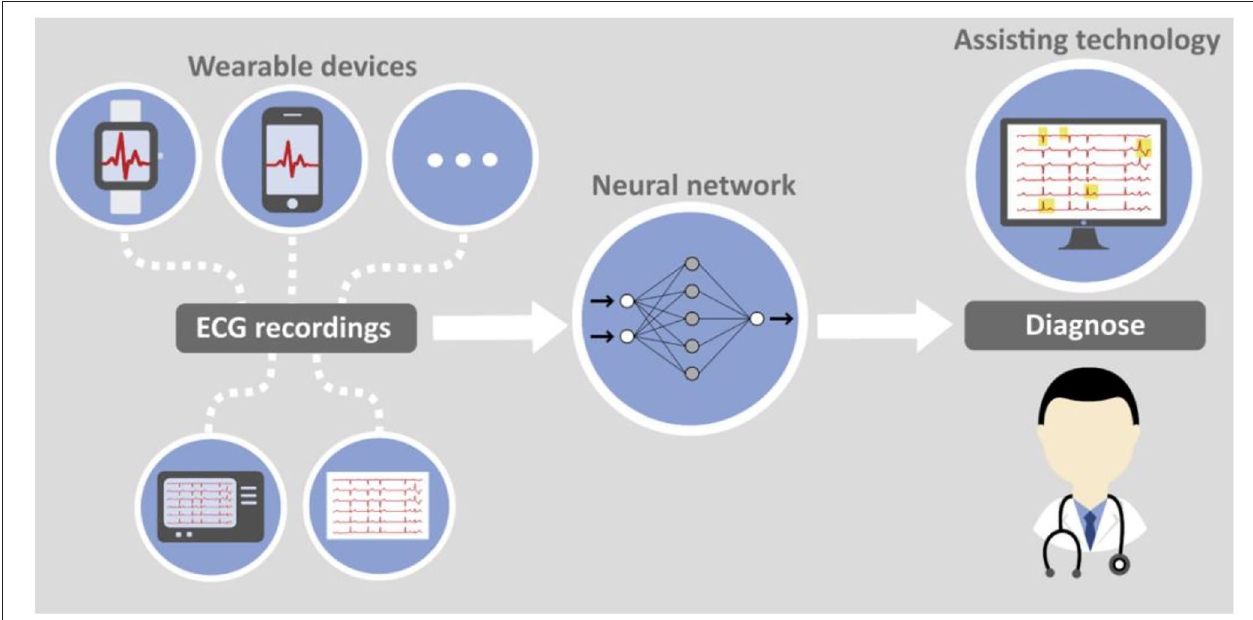
FIGURE 3 | Computer-aided ECG analysis with doctor and assisting